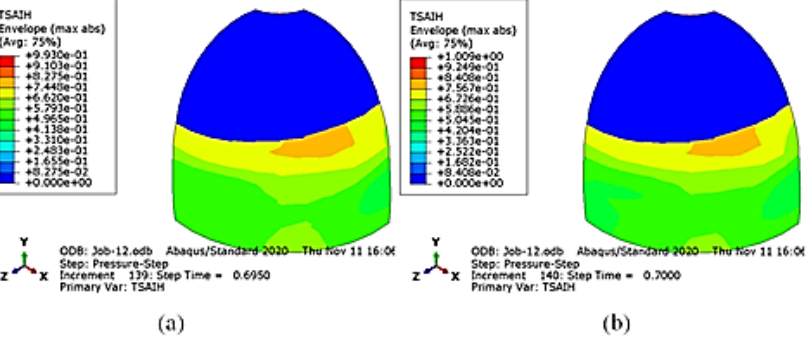
Figure 10. Tsai–Hill failure index (TSAIH): ( a ) lower than 1 at load step 0.695 and ( b ) greater than 1 at load step 0.7.